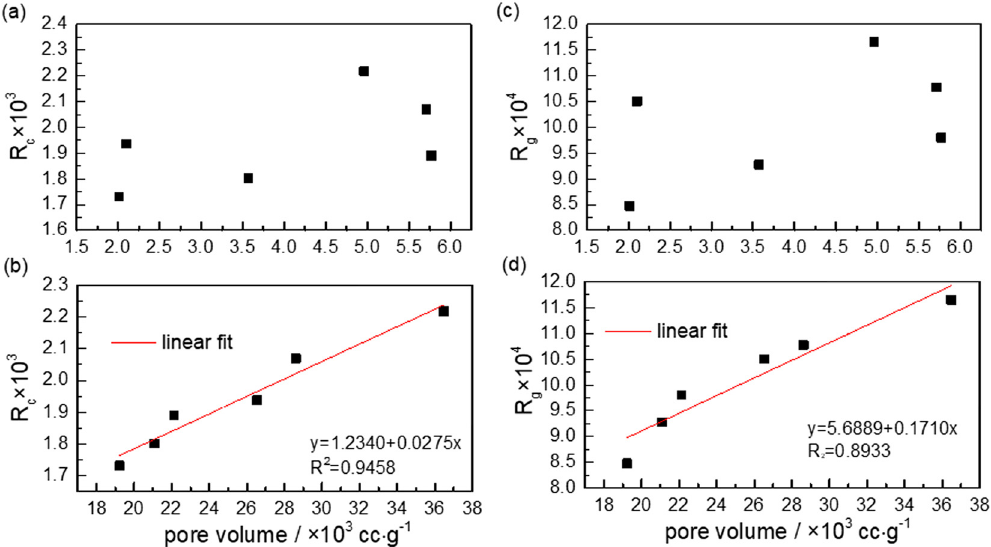
Figure 10: Relationships between semi - coke pore volume and reactivity indexes. ( a ) Micropore vs R c ; ( b ) mesopore vs R c ; ( c ) micropore vs R g ; ( d ) mesopore vs R g